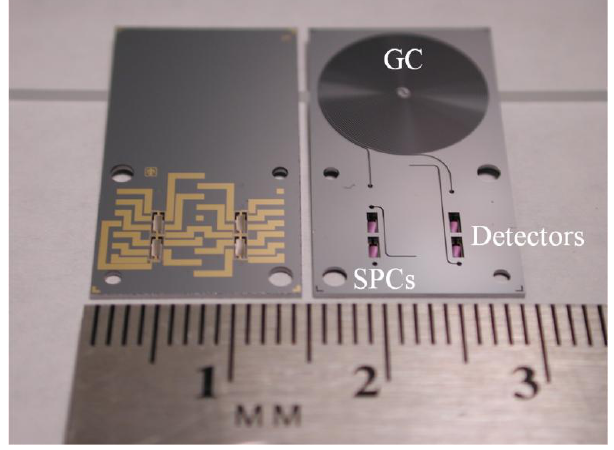
Figure 1. Two monolithically-integrated μGCs chips side-by-side. The chip on the left-hand side has the metallic traces used to electrically connect the PC and sensor shown face up. The chip on the right hand side is metal-side down to show the fluidic channels and deep reactive ion etched (DRIE) μGC